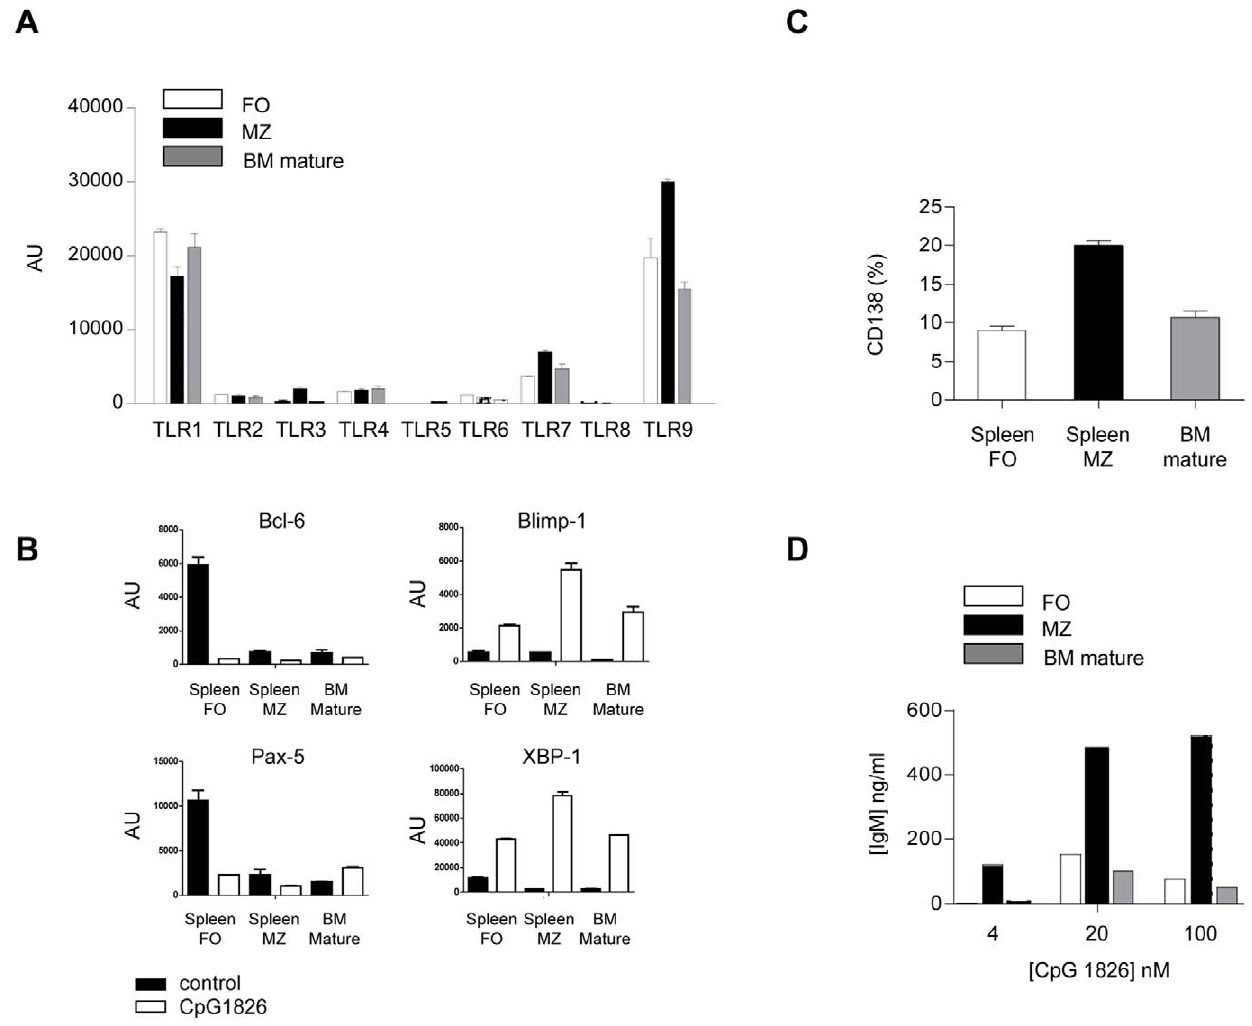
Figure 6. TLRs expression and response of BM mature, FO and MZ B cells to CpG 1826. (A) Representative experiment showing TLRs expression by quantitative real-time PCR on sorted resting B cell subsets. AU: arbitrary unit. Mean values of triplicates 6 SD from a single experiment are shown. (B) Expression of Bcl6, Blimp-1, Pax-5 and XBP-1 transcription factors by real-time PCR on the indicated B cell subsets either non stimulated (black bars) or after 48 h of stimulation with CpG at 100 nM (white bars). AU: arbitrary unit. Mean values of duplicates 6 SD from a single experiment are shown. (C) Percentages of CD138 + B cells after 4 day stimulation of the indicated B cell subsets with CpG 1826 at 100 nM. (D) IgM secretion by the indicated B cell subsets after 4 day stimulation with CpG 1826 at different